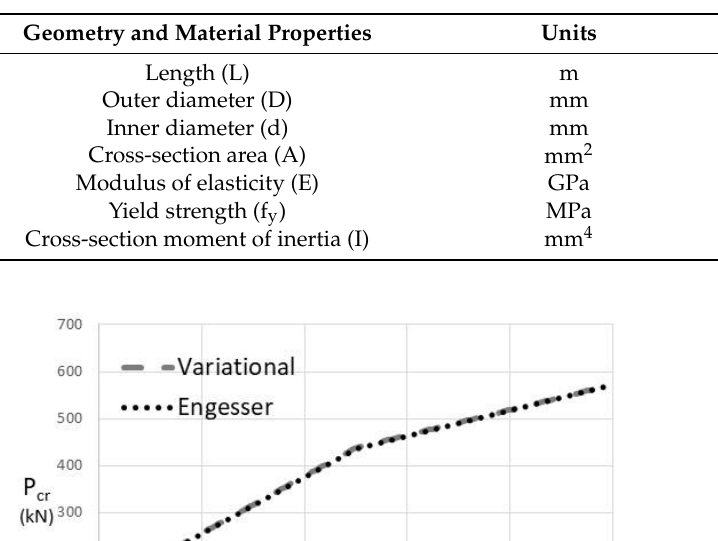
Table 1. Geometrical and mechanical characteristics of Titan 52/26 hollow bars for piles.